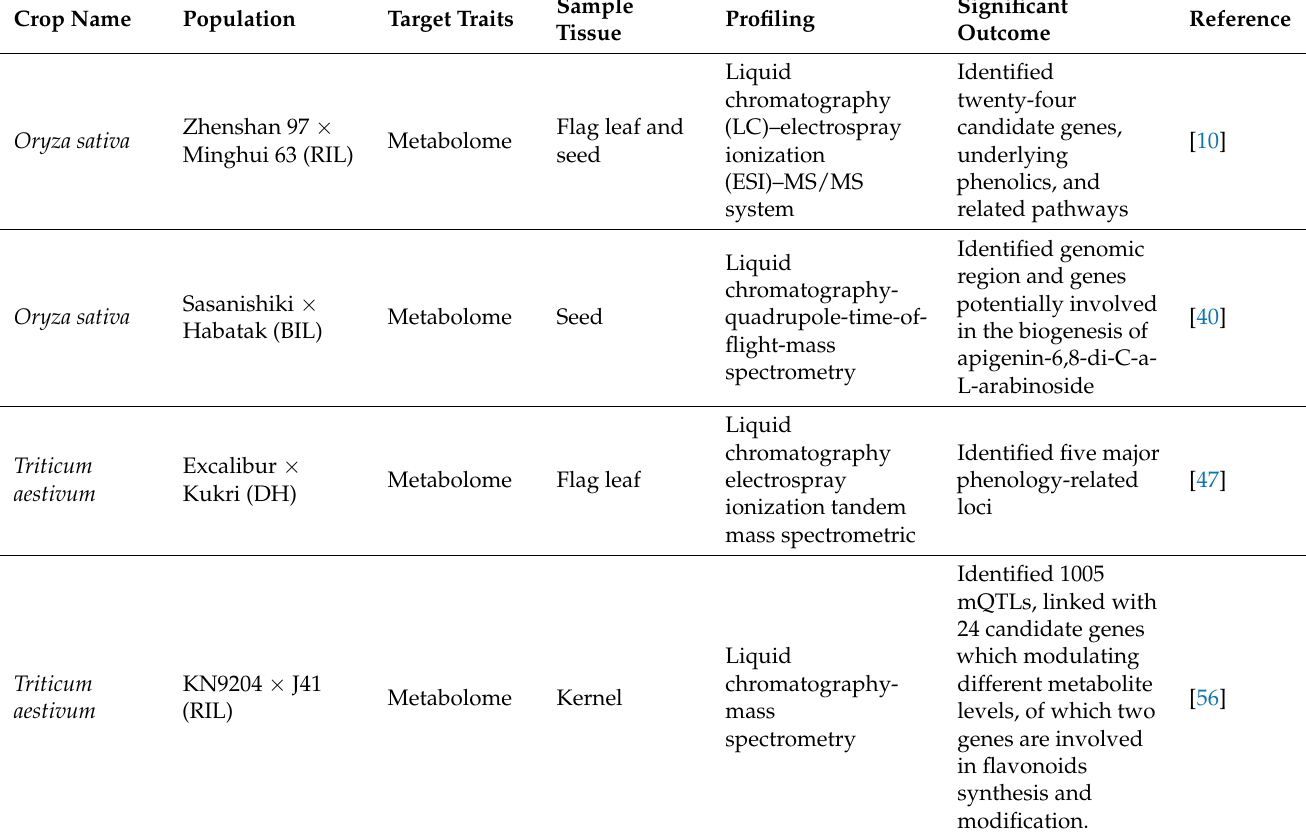
Table 1. Metabolomics-assisted breeding